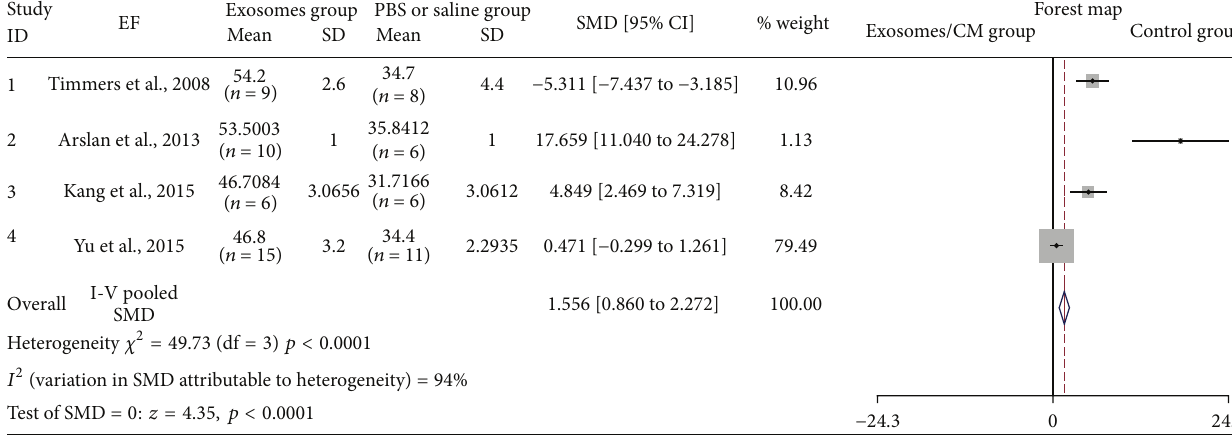
Figure 5: The effectiveness of exosomes on